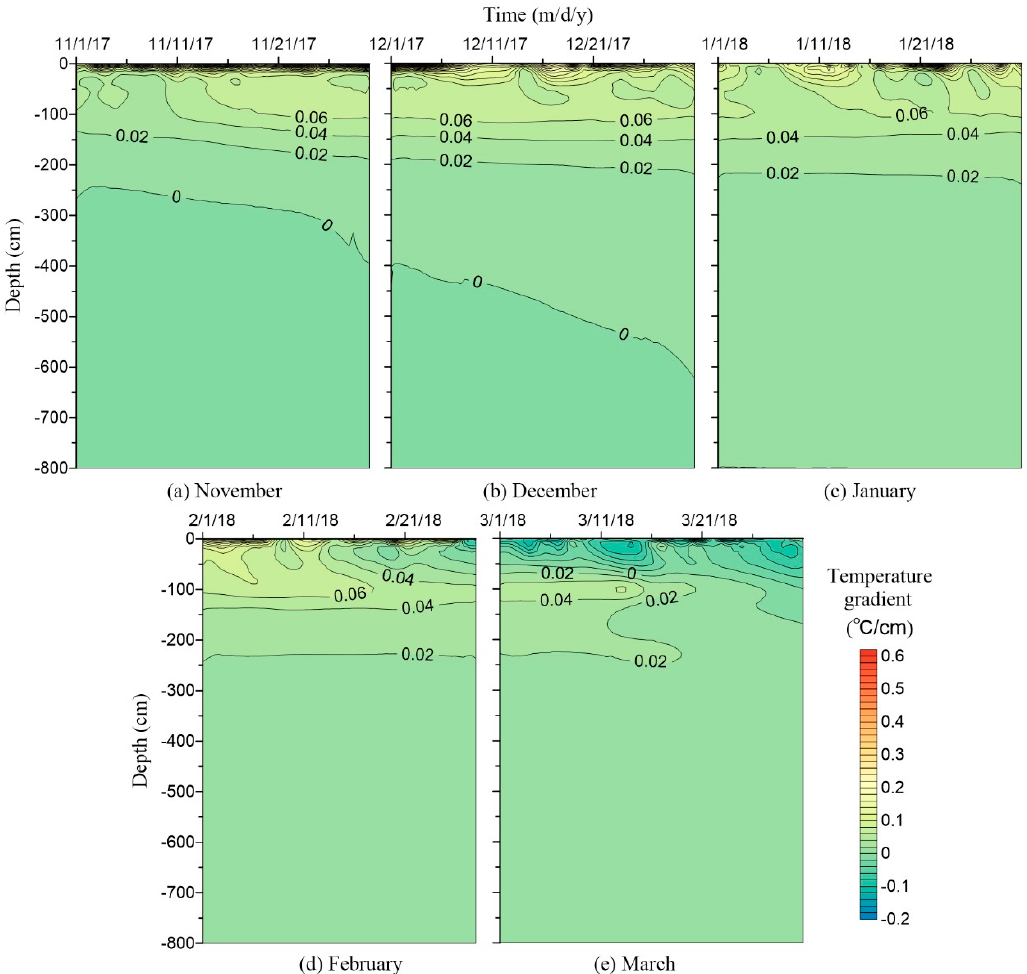
Figure 4. Spatial and temporal variations of soil temperature gradients during the months of ( a ) November 2017, ( b ) December 2017, ( c ) January 2018, ( d ) February 2018, and ( e ) March 2018. The temperature gradient was calculated as ∆ T / ∆ z = ( T i + 1 − T i ) / ∆ z , where T i + 1 and T i are soil temperatures at depths i and i + 1, respectively, and ∆ z is the vertical distance between depths i and i + 1.